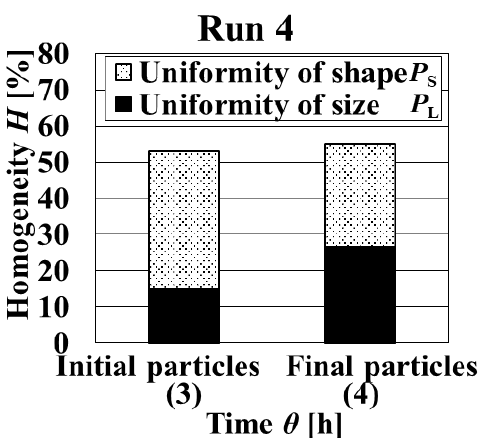
Figure 8. SEM photomicrograph of crystalline particles obtained in Run 4. ( a ) Initial particles. ( b ) Final particles.